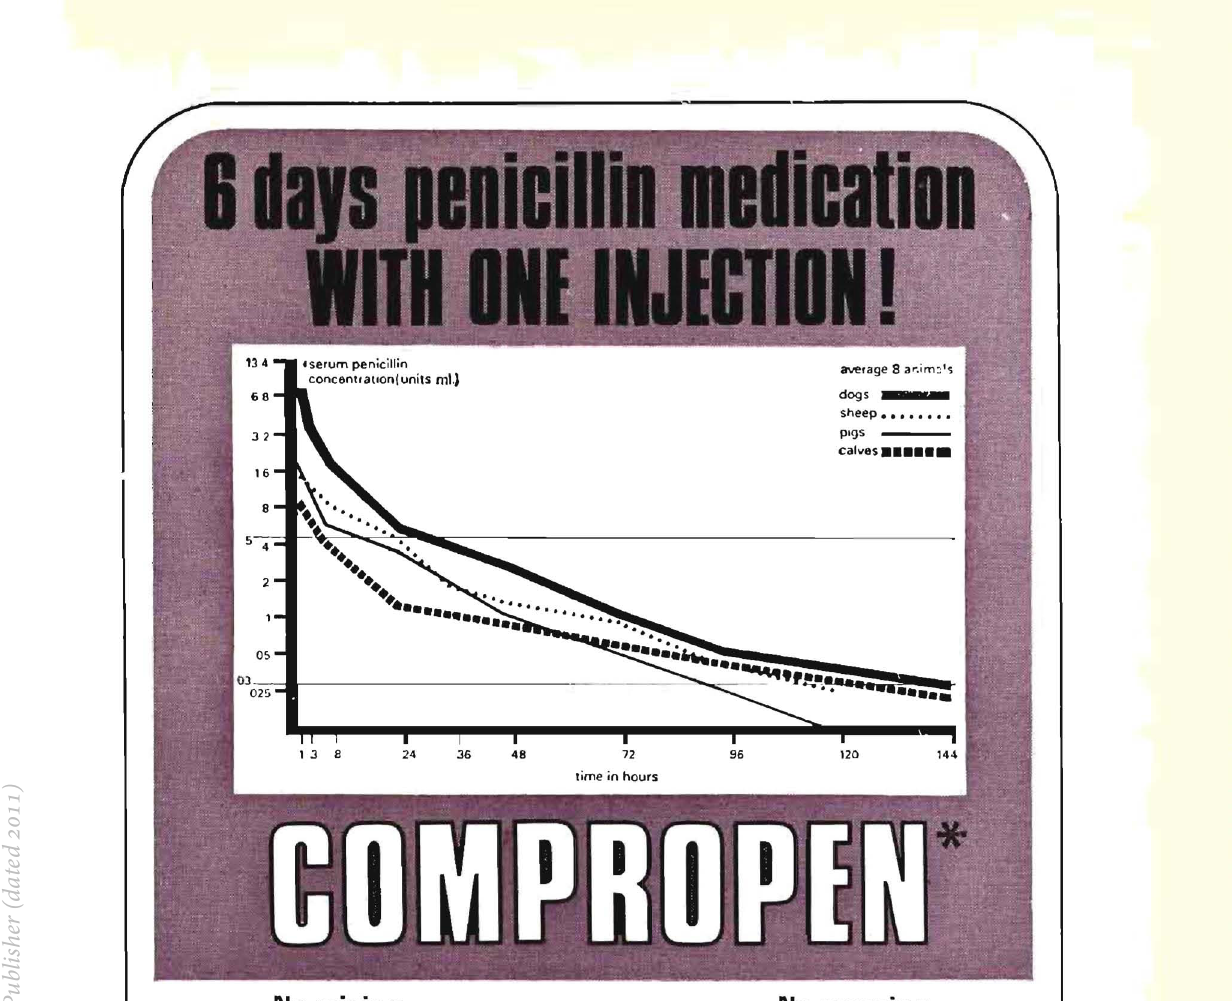
No mixing No messing For penicillin sensitive organisms, use Compropen-a combination of Benethamine and Procaine Penicillin. Bacteriocidal level of Penicillin within 1 hour of injection. Bacteriostatic level for up to 6 days. Easy ready-to-use suspension, Dose 1 ml. per 14 kg. (30 lb.) body